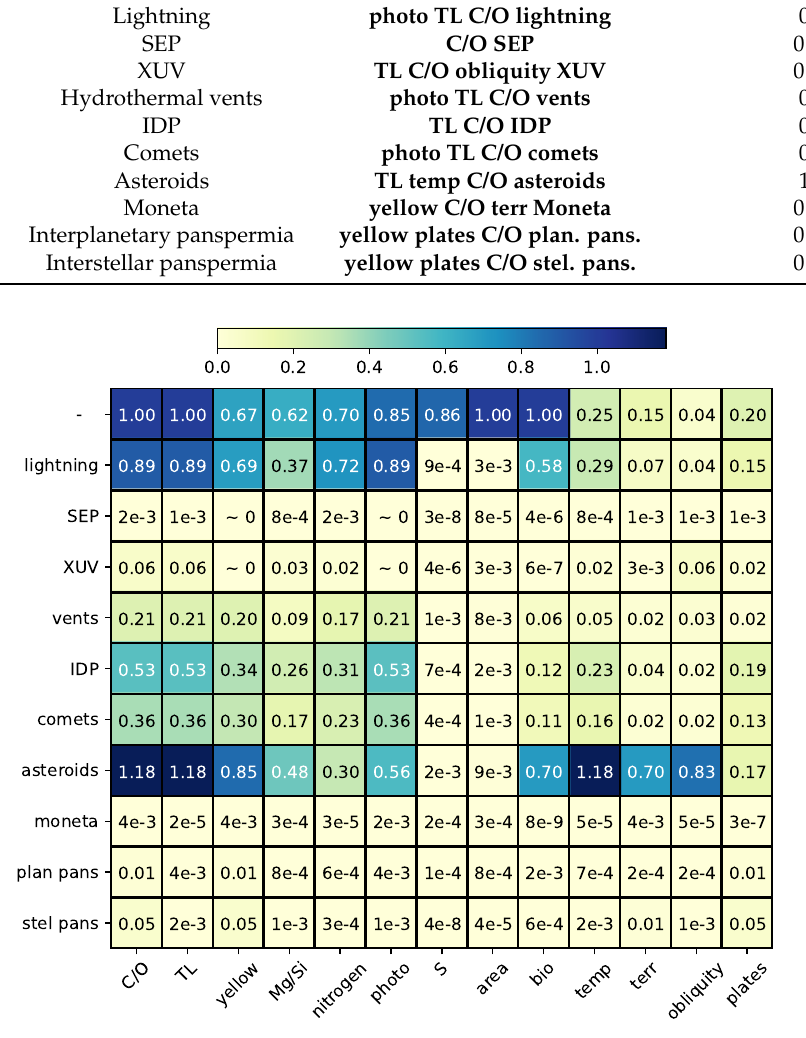
Figure 2. Bayes factors for different combinations of habitability criteria. Each entry in this matrix represents the best combination of criteria containing the origin of life scenario and habitability condition specified on their respective axes. Here we use the notation ae-x “ a ˆ 10 ´ x